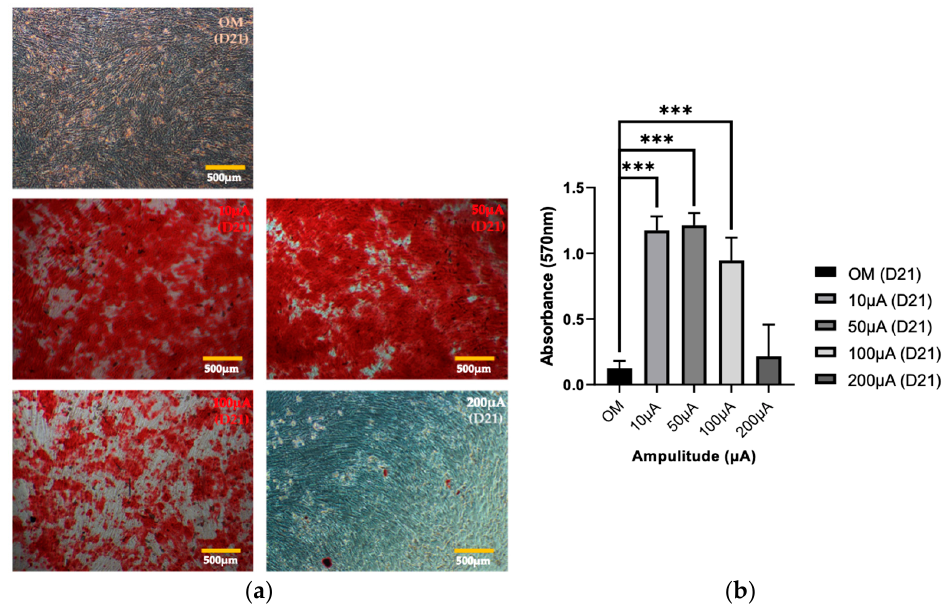
Figure 4. Mineralization in hADMSCs. ( a ) Optical images of ARS staining and ( b ) quantitative analysis using the CPC method (one-way ANOVA and Tukey’s HSD post-hoc test was performed, and error bars represent the standard deviation (SD), *** p < 0.001).